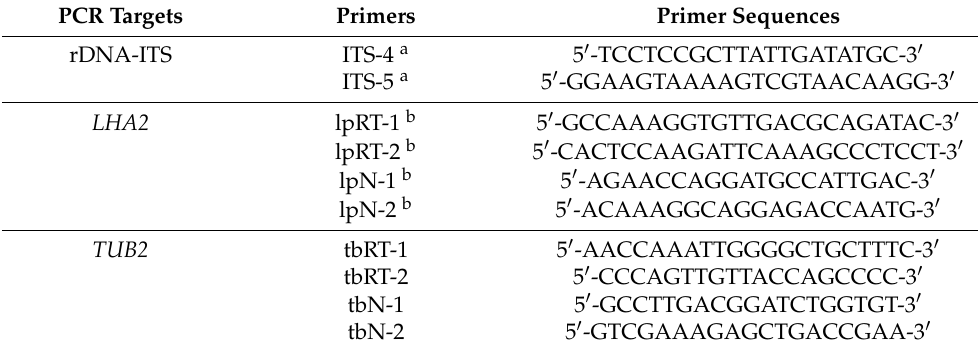
Table 1. Primers used in this